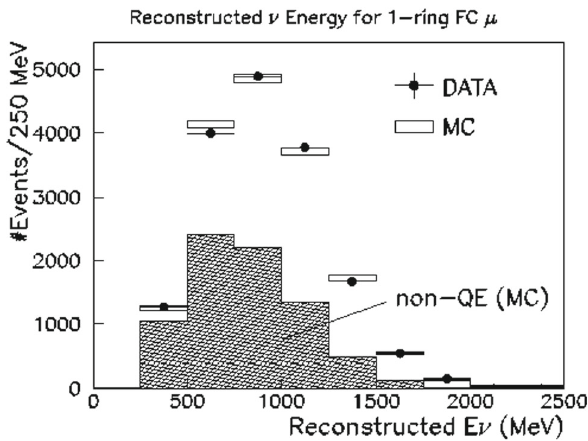
Fig. 39 The reconstructed neutrino energy distribution for single Cherenkov ring events in K2K. The hatched histogram shows the MC simulation of CC nonQE events. There is a non-negligible contribu- tion from inelastic charged current events (CC nonQE), where pions produced in the neutrino interaction are not recognized